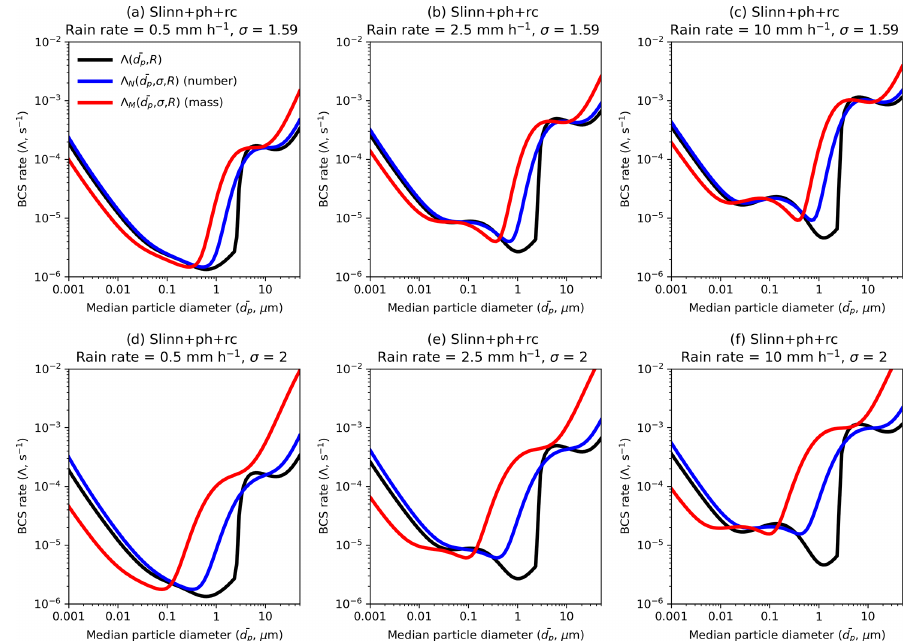
Figure 4. BCS rate integrated over aerosol mass and number (Eqs. 4–5) for geometric widths (a–c) σ = 1 . 59 and (d–f) σ = 2, as a function of aerosol diameter for rain rates representing (a, d) drizzle, (b, e) moderate rain, and (c, f) heavy rain.